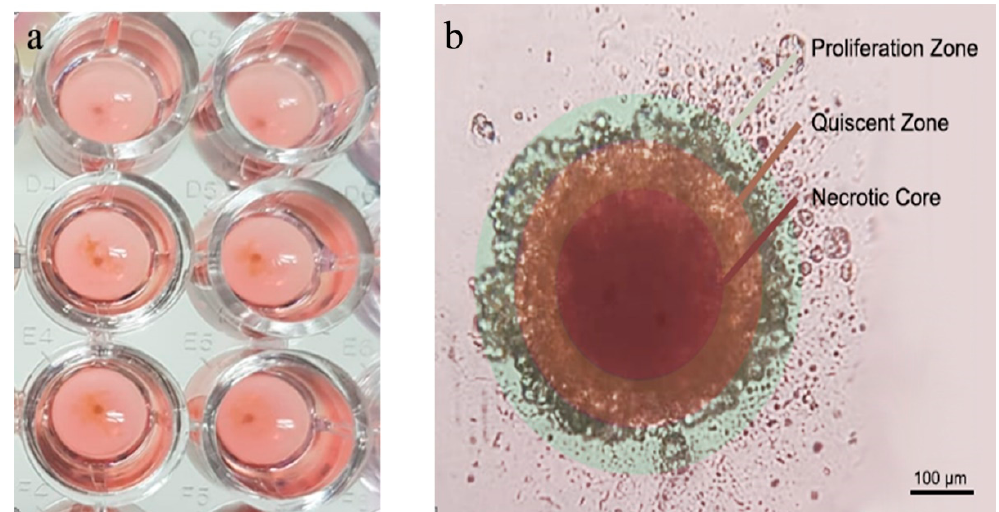
Figure 5. Individual 4T1 spheroids are formed in each well of microplates ( a ) also shown with